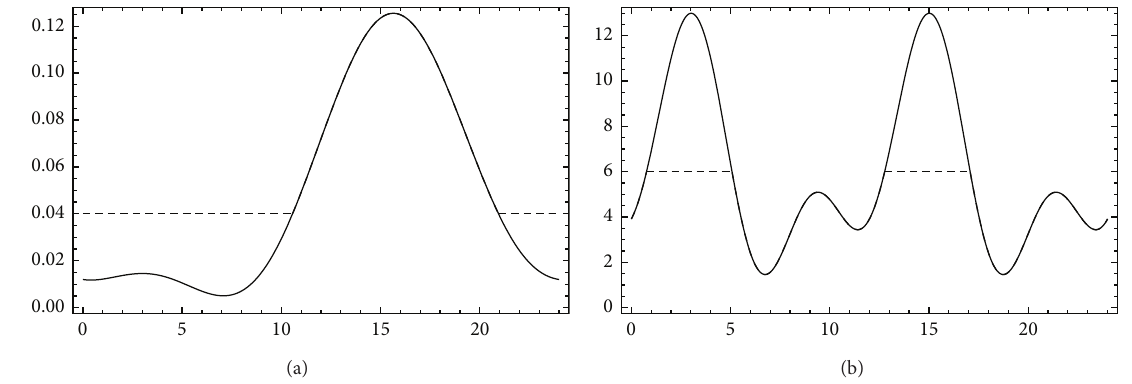
Figure 3: The graphs (solid lines) and a control strategy (dash line) of 𝛿(𝑡) (a) and 𝑆(𝑡) (b).